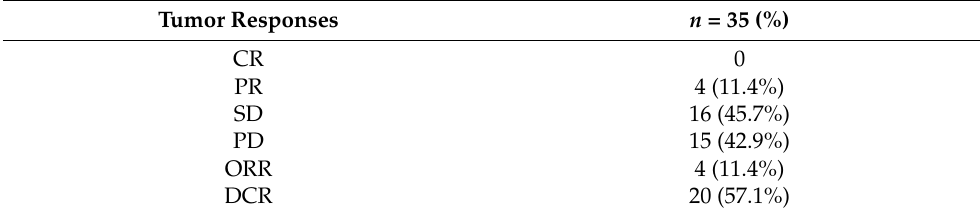
Table 2. Tumor response assessed according to mRECIST after two months of HAIC